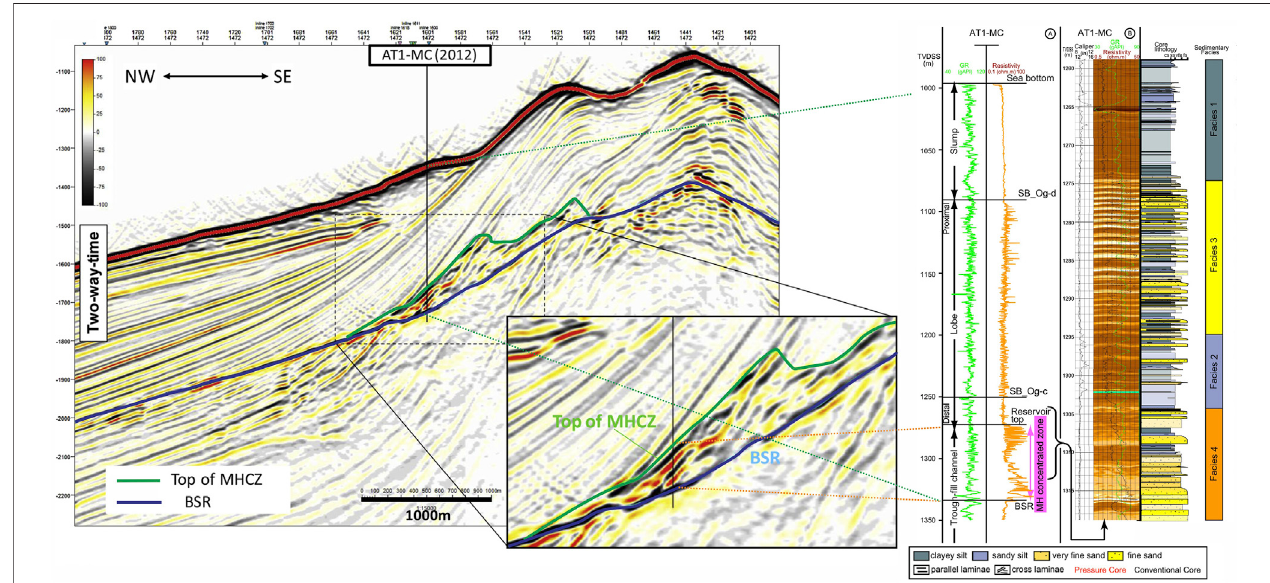
FIGURE 6 | Seismic re fl ection characteristics and sedimentary facies of high saturation hydrate deposits discovered during drilling in the Nankai Trough, Japan (Modi fi ed after Fujii et al., 2015; Komatsu et al., 2015). Note: High saturation hydrate deposits are located in the sand-rich turbidites with strong re fl ections above the BSR. MHCZ: methane hydrate concentrated zone.